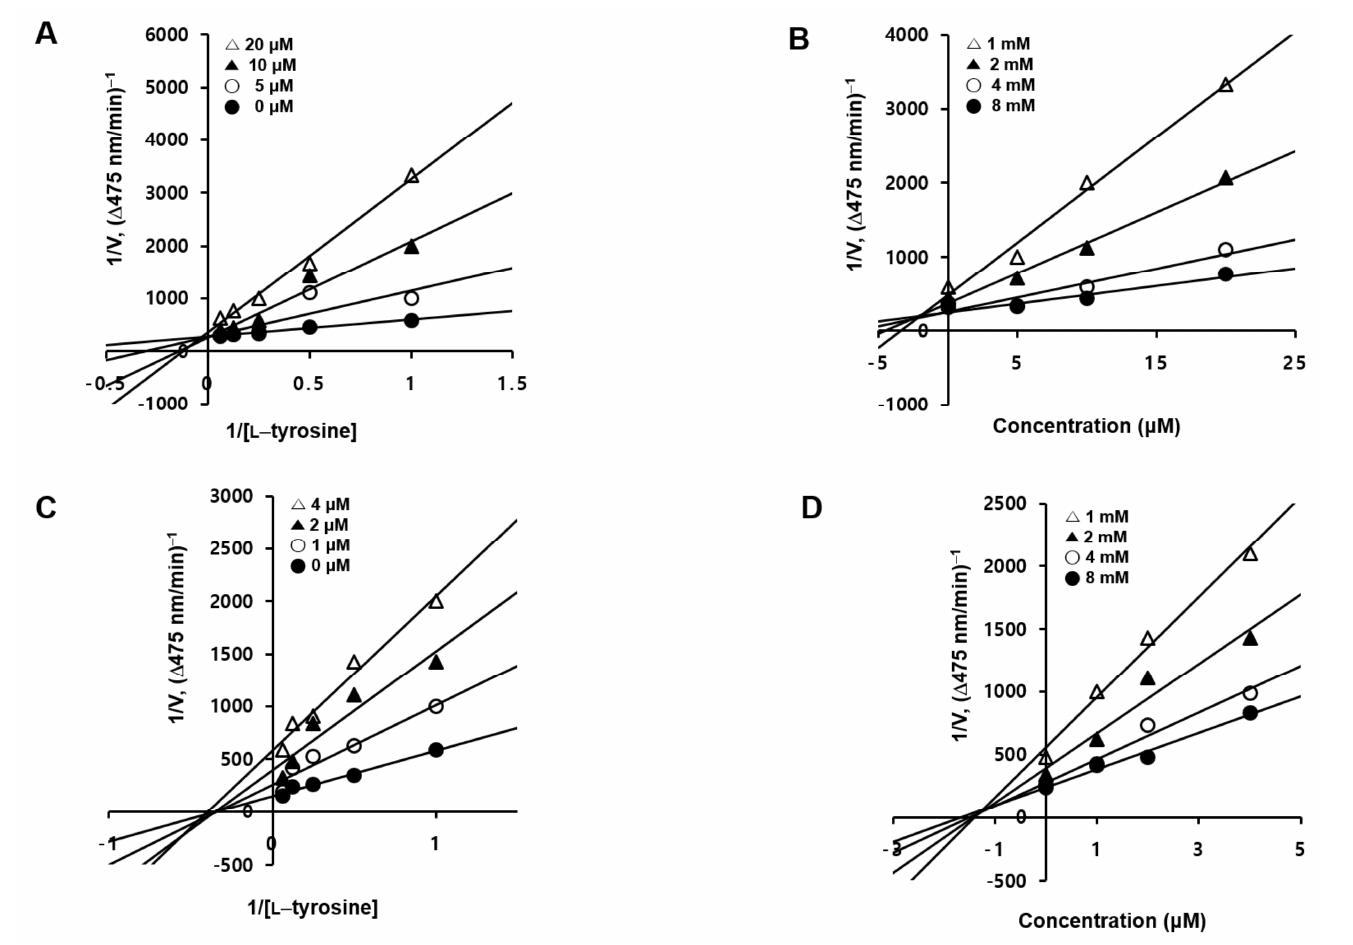
Figure 5. Kinetic studies of analogs 2 ( A , B ) and 3 ( C , D ) against mushroom tyrosinase in the presence of L ‐ tyrosine. Lineweaver–Burk plots ( A,C ) and Dixon plots ( B , D ) of 2 (0, 5, 10, or 20 μ M) and 3 (0, 1, 2, or 4 μ M) are shown. Data in ( A , C ) are mean 1/V values (defined as the inverse of the rate absorbance increase at 475 nm) at 5 different L ‐ tyrosine concentrations (1, 2, 4, 8, and 16 mM). Data in ( B , D ) are mean 1/V values at 4 different analog concentrations.